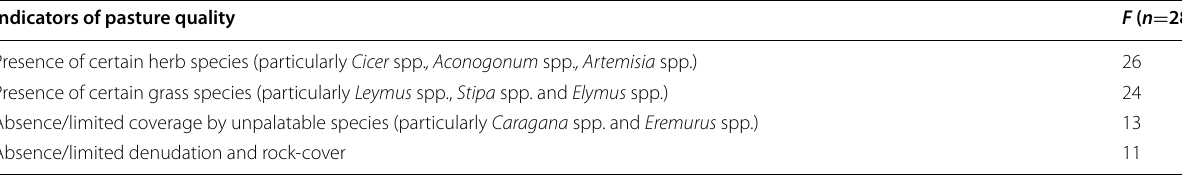
Table 4 Frequency ( F ) of indicators of pasture quality based on interviews with 28 migratory herders Indicators of pasture quality